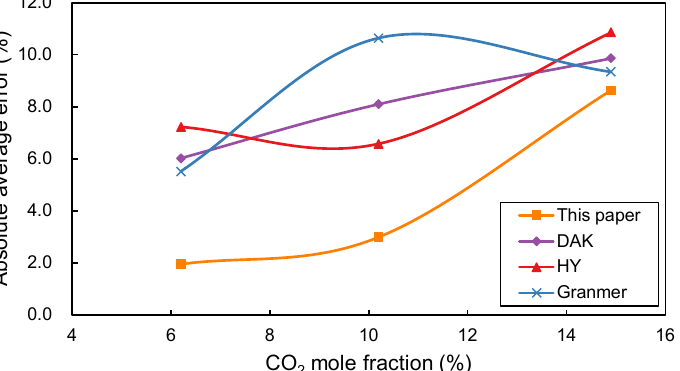
Figure 3. The effect of different CO 2 contents in the natural gas system on the compressibility factor calculation by the four empirical